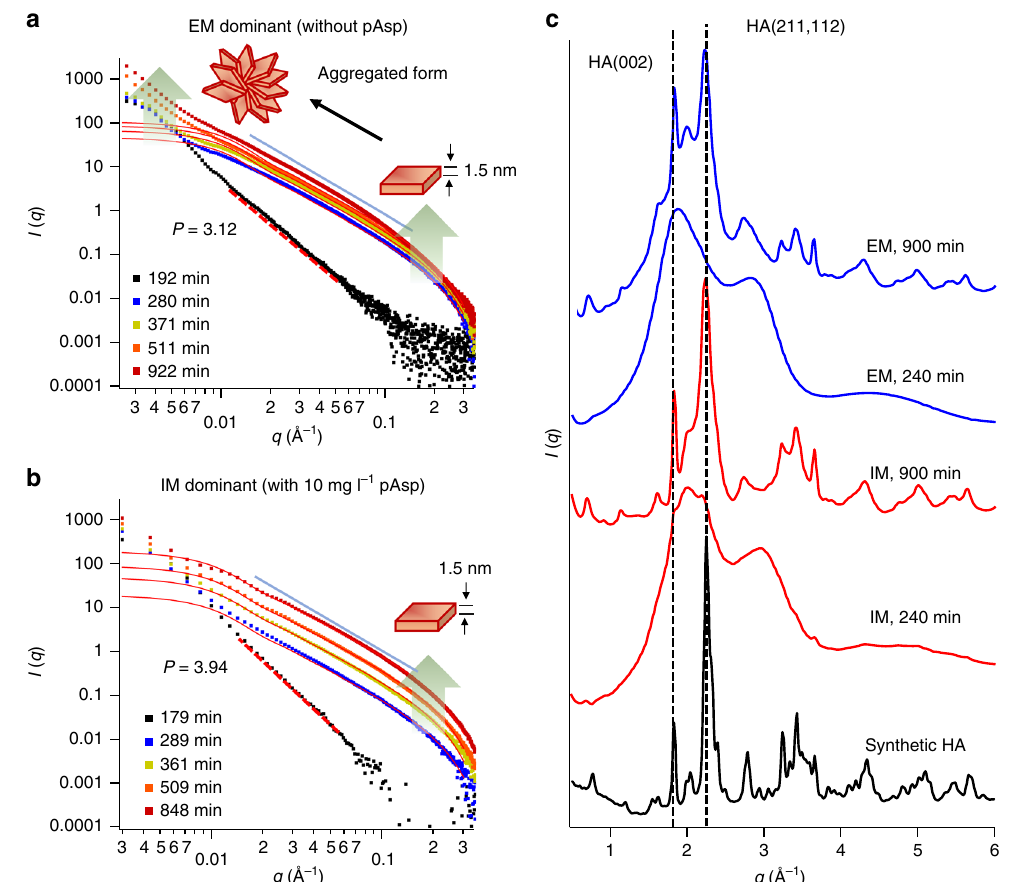
Fig. 2 In situ SAXS/WAXD patterns from collagen matrices during mineralization. Data collected from unmineralized collagen was used for background subtraction. a , b Small-angle X-ray scattering (SAXS) patterns collected during mineralization without pAsp for extra fi brillar mineralization (EM, a ) and with pAsp for intra fi brillar mineralization (IM, b ) in the 2.85 × SBF solution. Red solid lines fi t plate-like particles (height: 1.5 nm and length: 40 nm). P values are the slopes of the Porod regime at 179 and 192 min , in red dotted lines ( I ( q ) ∝ q - P ). The solid light blue lines show negative slopes of 2 in the log-log plot after the induction time, indicating the 2-dimensional morphology of nuclei. c Wide-angle X-ray diffraction (WAXD) patterns of CaP formed in collagen matrices at early (240 min) and later (900 min) stages of mineralization. Synthetic hydroxyapatite (HA) was analyzed for